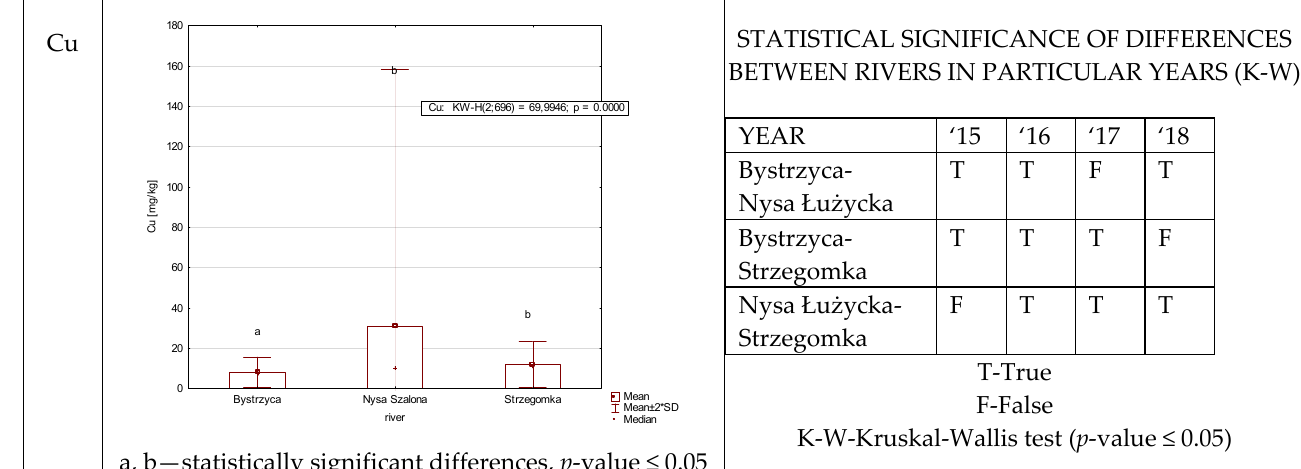
Figure 2. Cu concentration in plants from rivers across 29 sites depending on river (graph to the ( left )) and by year 2015–2018 in the table to the ( right ). Statistically significant differences are marked in the graph with letters a, b and in the table these differences are shown by year between rivers—T—differences were present, F—no statistical difference ( p -value ≤ 0.05).